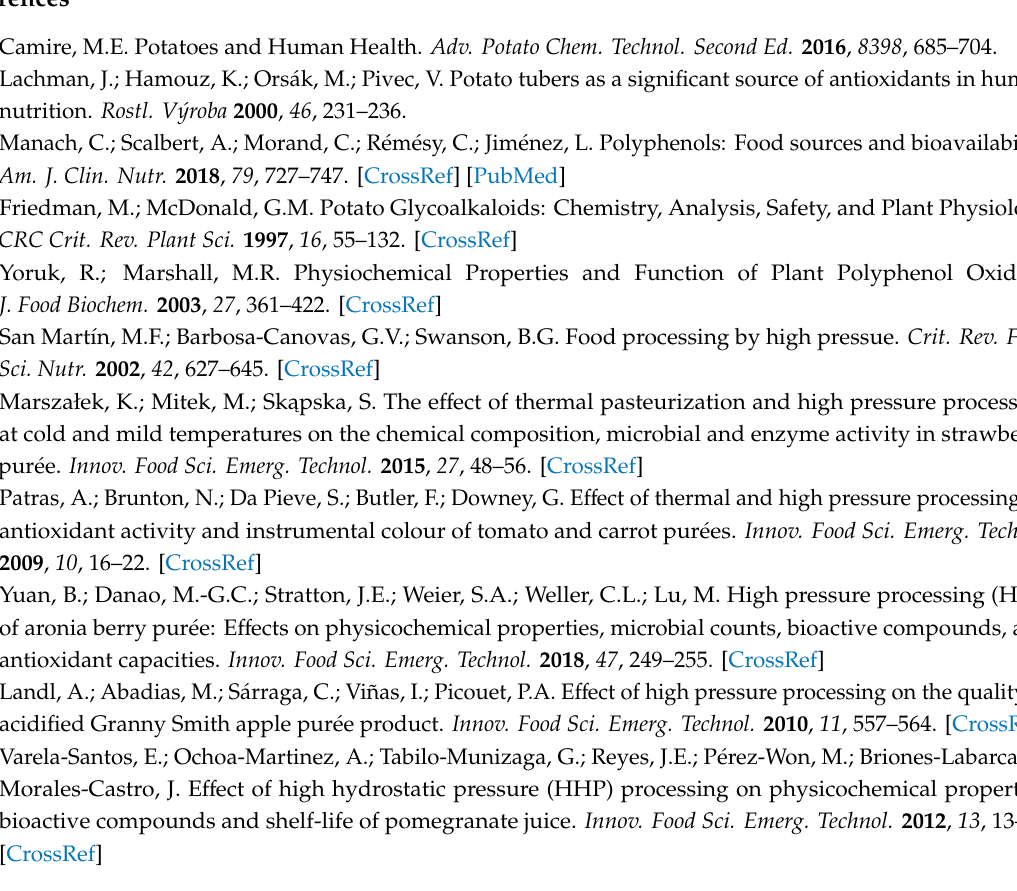
Figure S1: HPLC-Q-Tof-MS profiling of the phytochemicals in the potato Saxon extract. Shown in the inset is the LC chromatogram where the polyphenols and glycoalkaloids elute between 2–9 min, Figure S2: UPLC-TQD-MS quantification of polyphenols in the di ff erent potato cultivars prior to (left column) and post-HPP (right column). As evident from the total ion chromatograms (TIC) that chlorogenic acid is the most abundant polyphenol in potatoes, which is reduced in the post-HPP samples with an increase in ca ff eic acid, Table S1: Tentative identification of phytochemicals from the potato (Saxon) extract using accurate mass measurement and MS / MS fragment